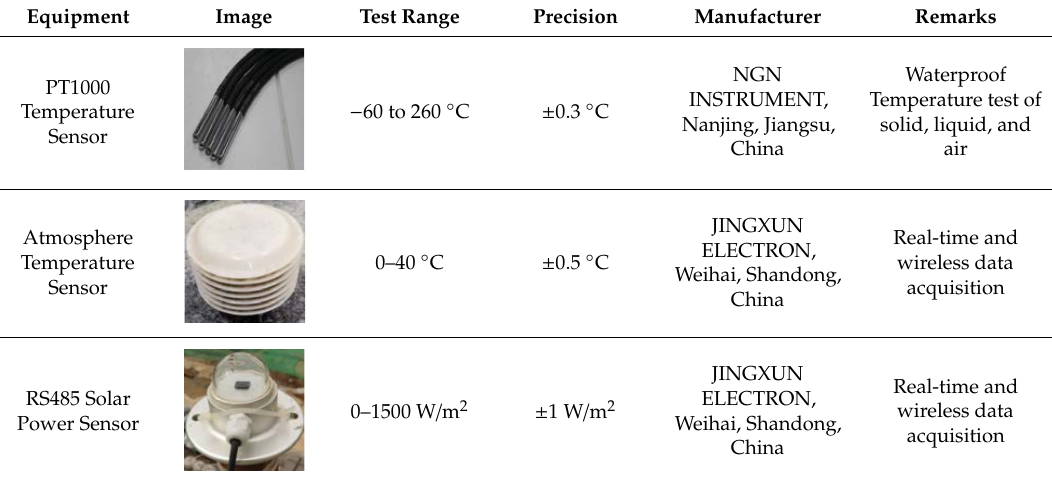
Table 1. List of test equipment.